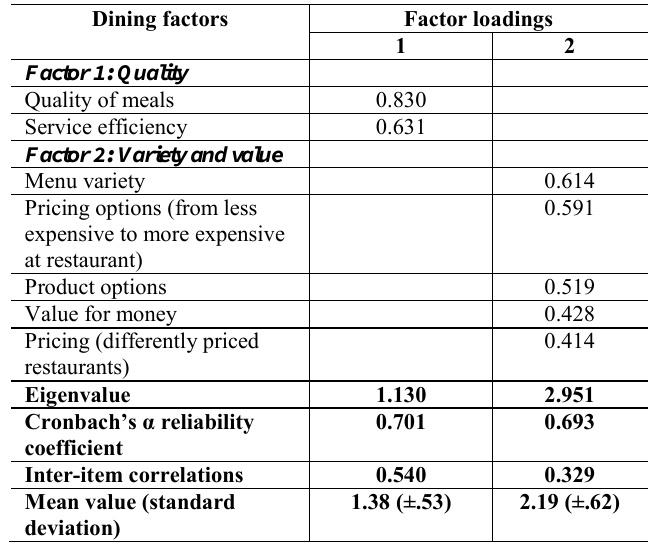
Table 2: Results of the factor analysis for